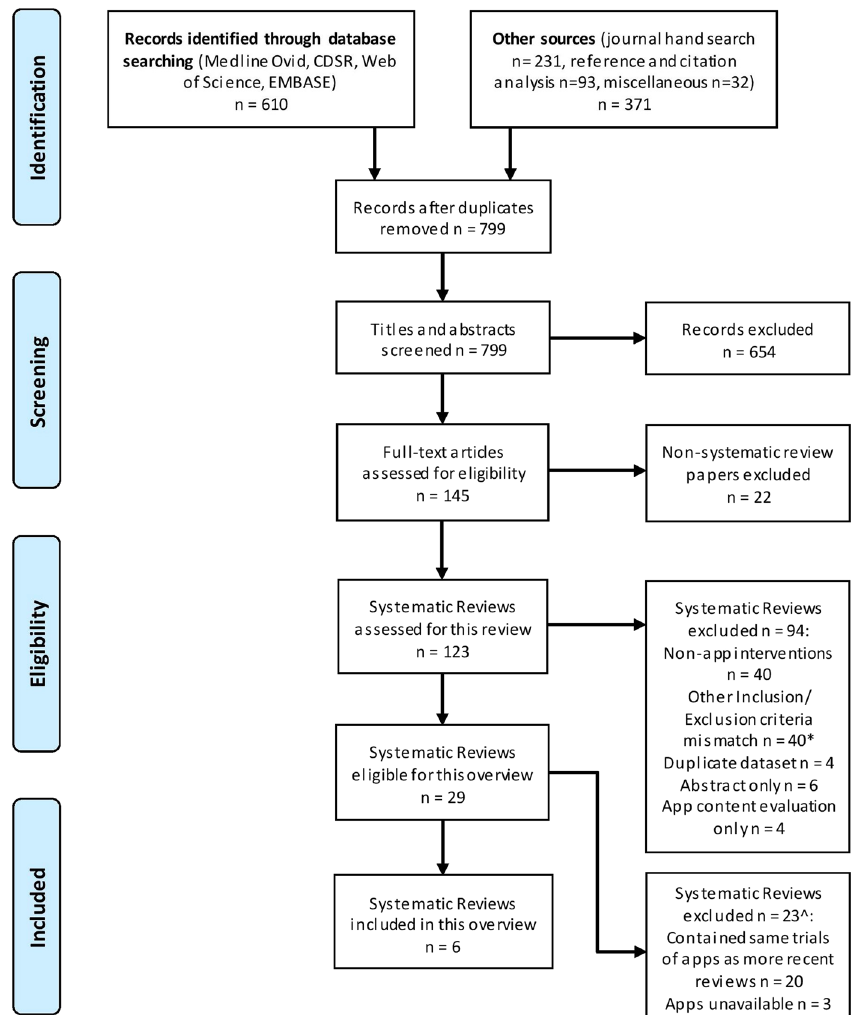
Fig. 1 PRISMA fl ow diagram of selection of systematic reviews. *Table of excluded articles due to Inclusion and Exclusion criteria mismatch is provided as Supplementary Information 1. ^Table of excluded articles due to repeated coverage is provided as Supplementary Information 2